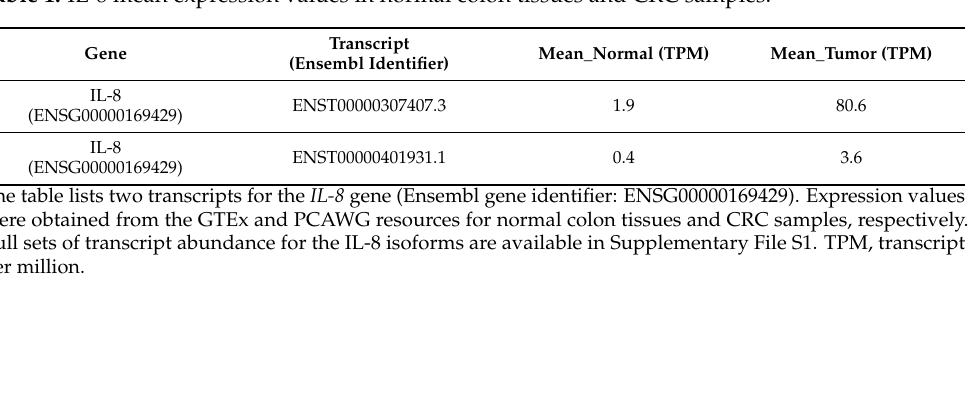
Figure 2. Analysis of IL-8 in CRC patients. ( A ): IL-8 expression in normal and CRC tissues. Boxplots show expression values of the IL-8 gene across 51 CRC samples from the PCAWG resource (“tumor”) and 88 colon samples from the GTEx resource (“normal”) for two transcripts annotated for this gene: ENST00000401931.1 (left panel) and ENST00000307407.3 (right panel). Expression values are given as log2-transformed transcript per million (TPM). ( B ): Representative CRC cases showing PTEN-loss/IL-8 infiltrate low and IL-8 tumor high images (top panels) and PTEN competent/IL-8 infiltrate high and IL-8 tumor images (bottom panels). Scale bar = 30 µ m. Patients carrying PTEN gene inactivating alterations or completely lacking PTEN protein expression (IHC score 0) are referred to as PTEN-loss. ( C ): Distribution of PTEN competent and PTEN-loss patients according to IL-8 tumor and infiltrate levels. Arrows indicate low or high levels of IL-8. Table 1. IL-8 mean expression values in normal colon tissues and CRC samples.